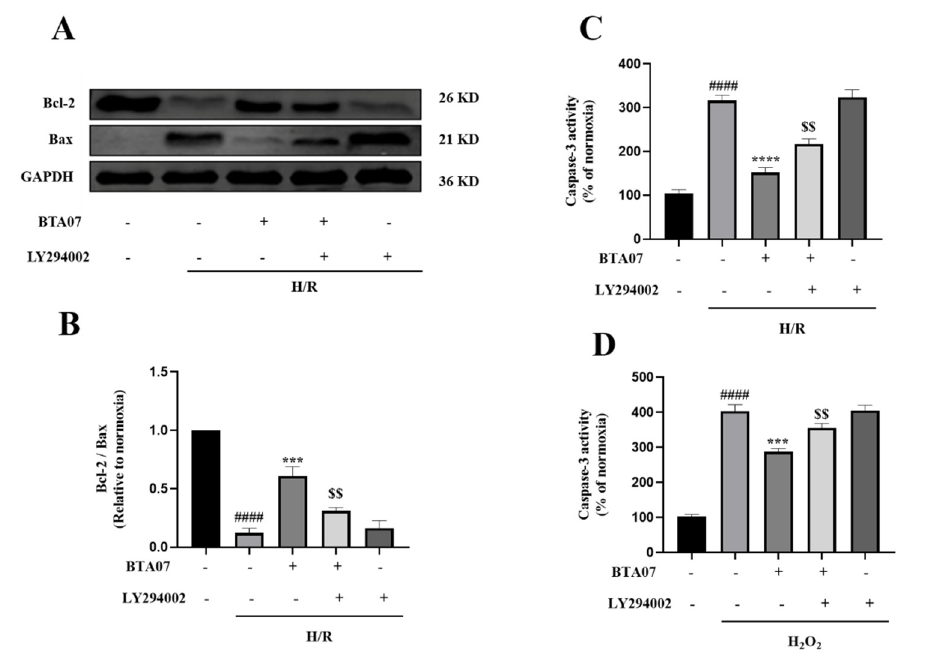
Figure 8. BTA07 inhibited H/R-induced apoptosis in ARCMs via the PI3K/Akt signaling pathway. ( A , B ) Expression of Bax and Bcl − 2 were measured by Western blot. ( C ) Caspase − 3 activity in ARCMs. ( D ) Effects of BTA07 on ARCMs caspase-3 activity after H 2 O 2 was induced. Data are presented as means ± S.E.M for three independent experiments. #### p < 0.0001 vs. normoxia group; **** p <0.0001vs. vehicle group; *** p <0.001vs. vehicle group; $$ p <0.01vs. BTA07 group; one − way